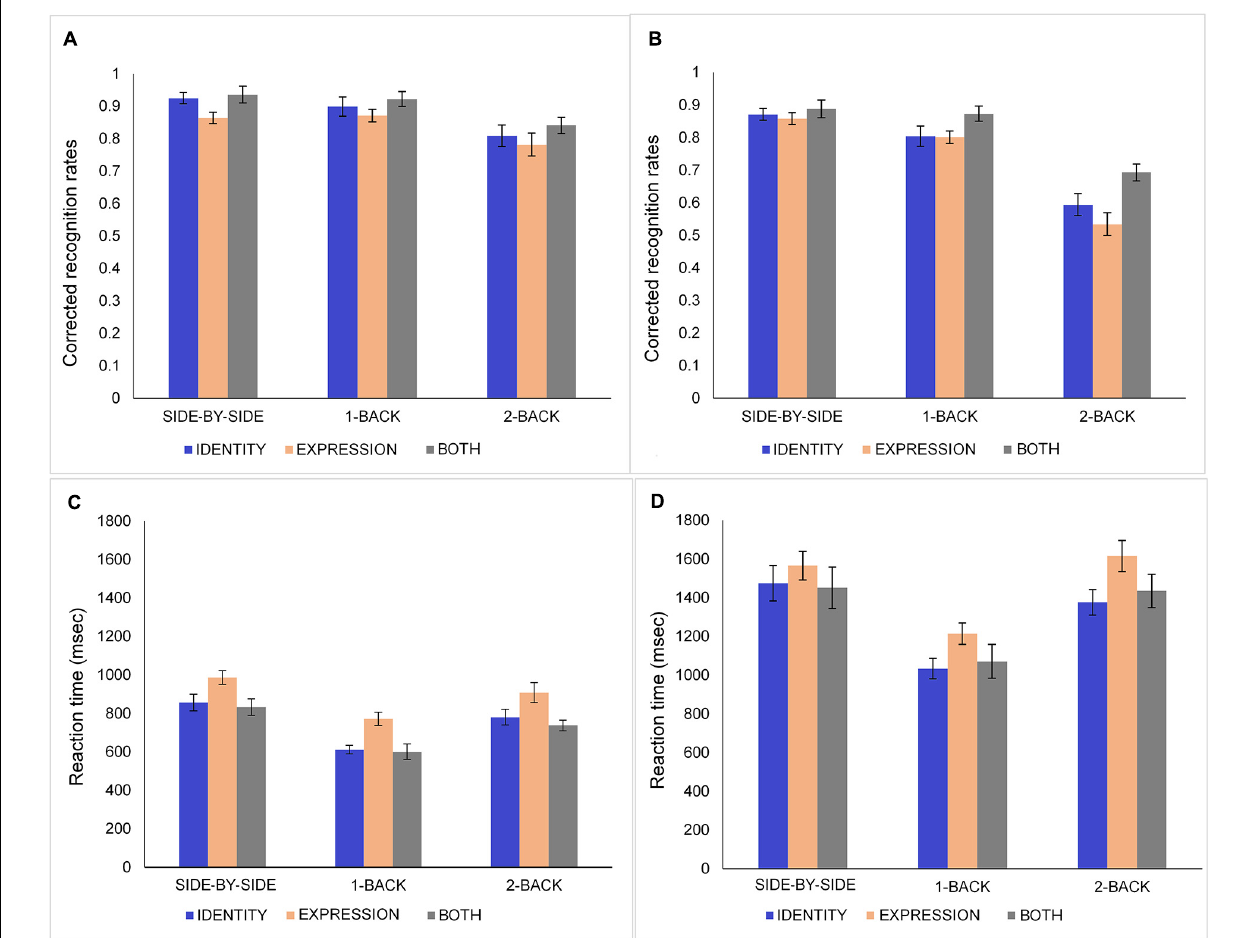
FIGURE 2 | Corrected recognition rates (proportion of hits minus false alarms) and response times of younger (A,C) and older (B,D) adults in the identity, expression, and both conditions for side-by-side 0-Back, 1-Back, and 2-Back tasks. Error bars denote standard error.